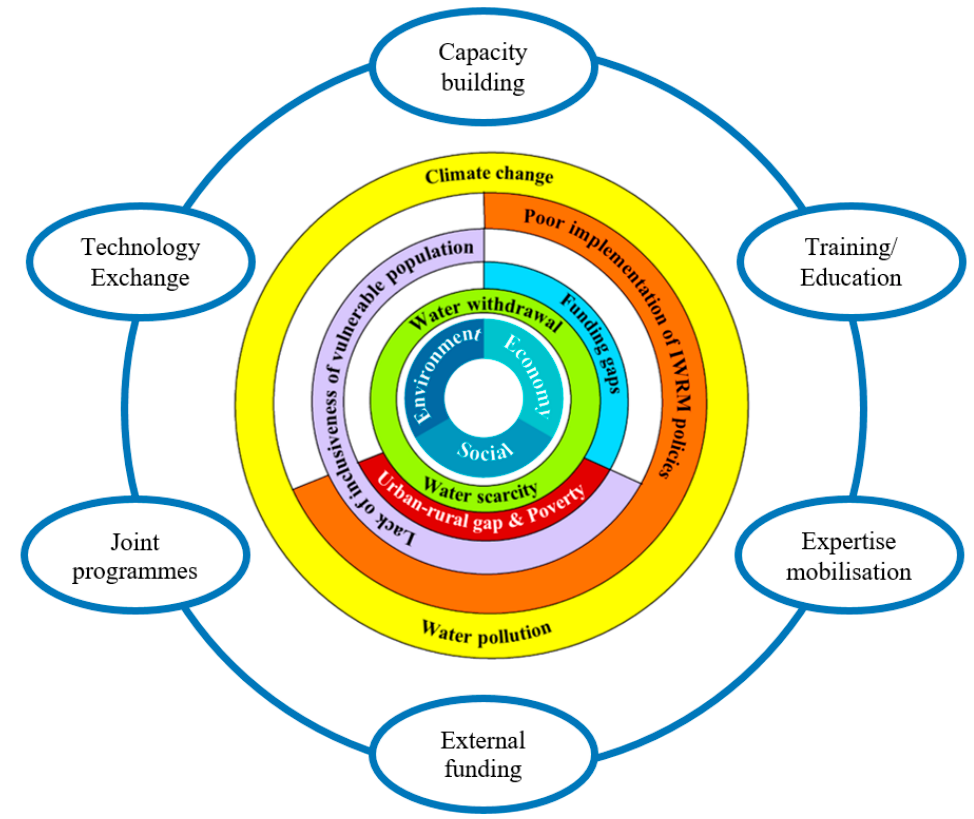
Figure 5. Water security challenges faced by Southeast Asian countries and possible strategies to mitigate them.